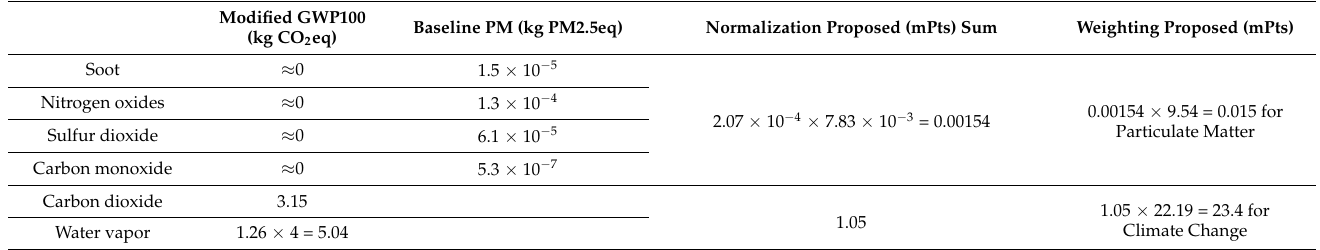
Table 5. Proposed approach for ILCD 2011